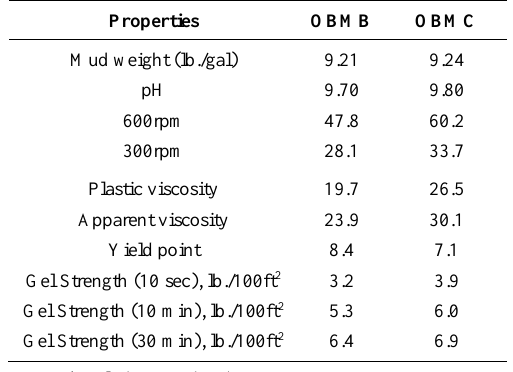
Table 3. Results obtained from the experiment at optimum process conditions